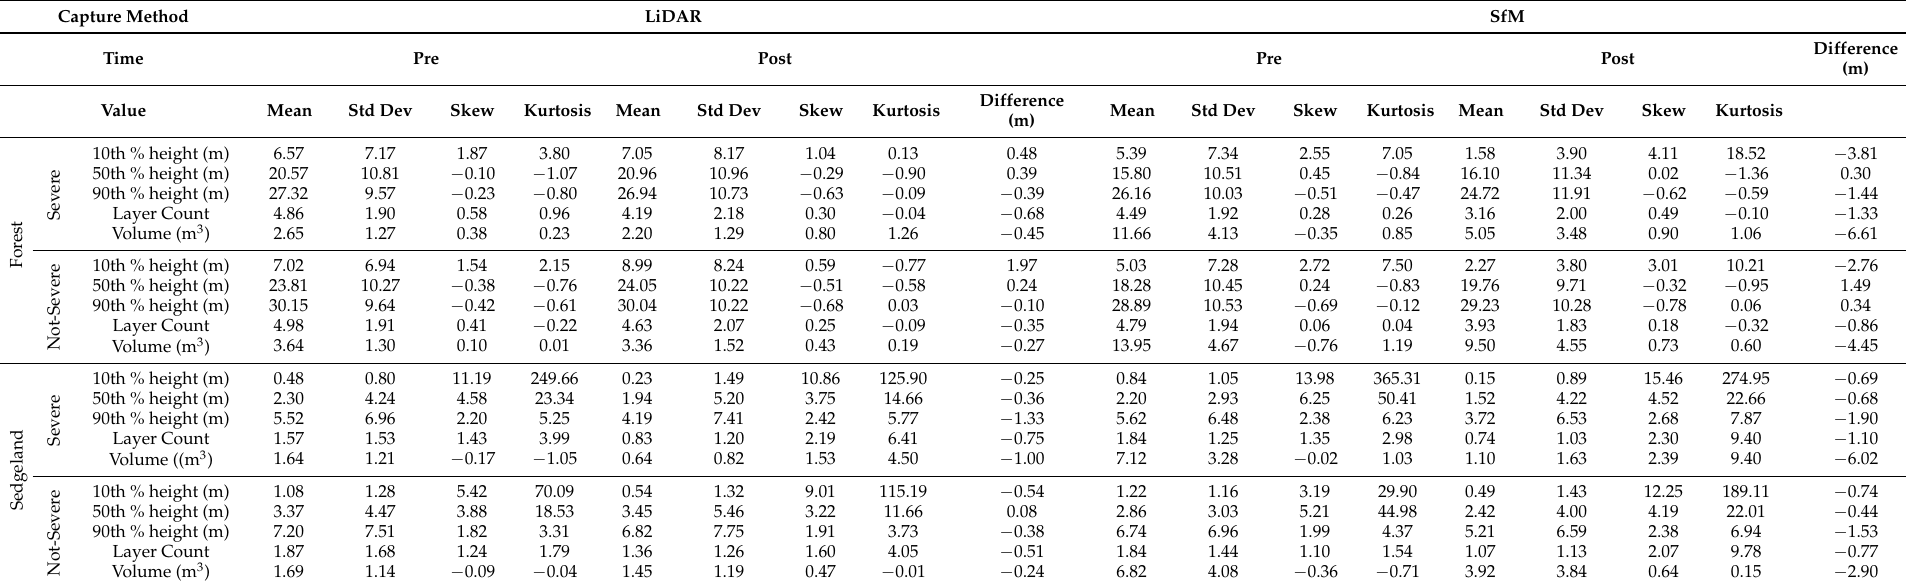
Table 14. Vertical structure change separated by the classification of the vegetation and severity